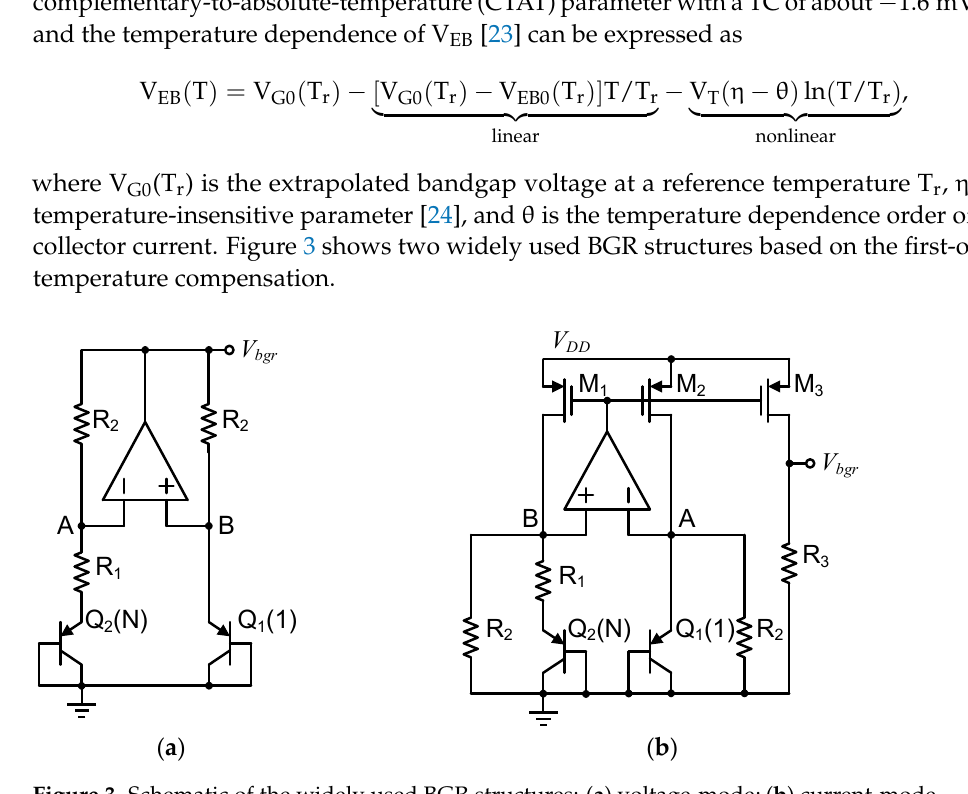
Figure 3. Schematic of the widely used BGR structures: ( a ) voltage-mode; ( b ) current-mode.